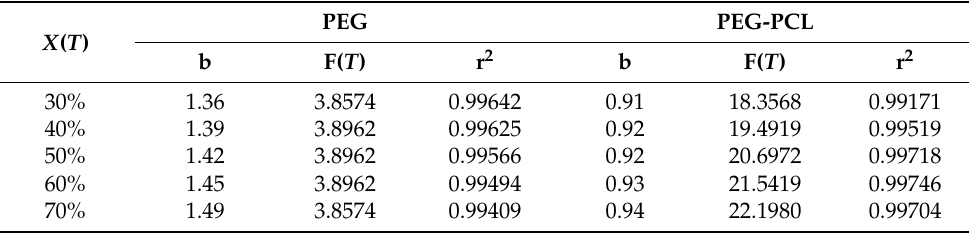
Figure 6. ( a ) PEG ( b ) PEG-PCL non-isothermal crystallization of ln Φ vs. ln t . At the same time, F( T ) and b are summarized in Table 5. The b value of PEG and PEG-PCL increases with the increase in crystallinity. For PEG, b > 1, which means that the Avrami exponent of PEG is greater than the Ozawa exponent. For PEG-PCL, b < 1, which indicates that the Avrami exponent of PEG-PCL is smaller than the Ozawa exponent. For PEG, the F( T ) value does not change much with the increase in crystallinity. The F( T ) of PEG-PCL increases with the increase in crystallinity, which means that the crystallization rate of PEG-PCL decreases with the increase in crystallinity. Meanwhile, the F( T ) of PEG is lower than that of PEG-PCL, indicating that the crystallization rate of PEG-PCL is slower than that of PEG, and this is consistent with the above results. Table 5. Values of PEG and PEG-PCL parameters under Mo